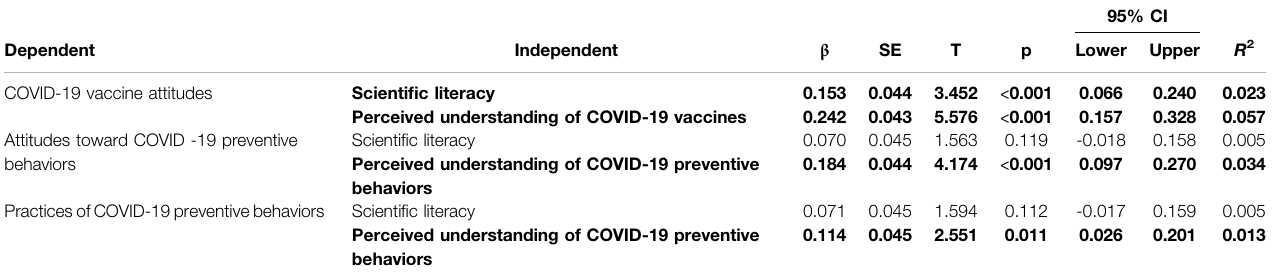
TABLE 2 | Roles of scienti fi c literacy and perceived understanding on attitudes toward vaccines and attitudes/practices of COVID-19 preventive